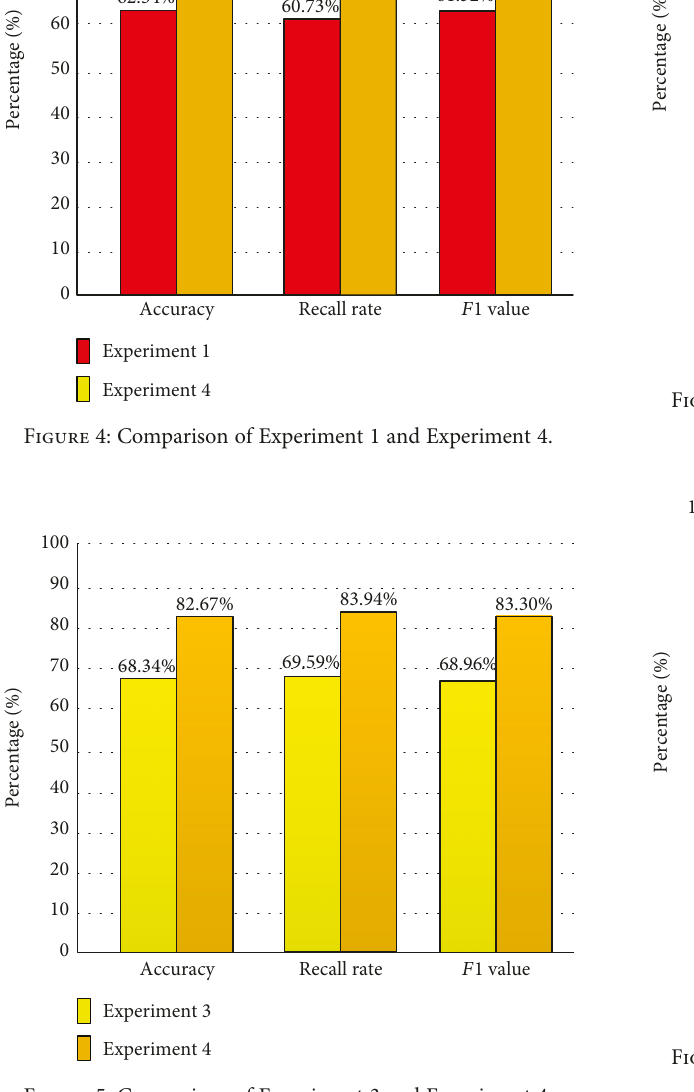
Figure 5: Comparison of Experiment 3 and Experiment 4.